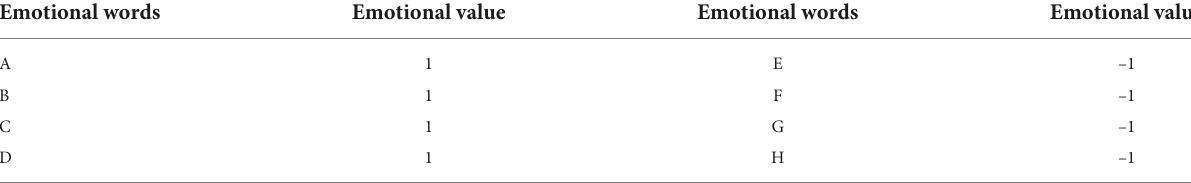
TABLE 1 Example of a sentiment